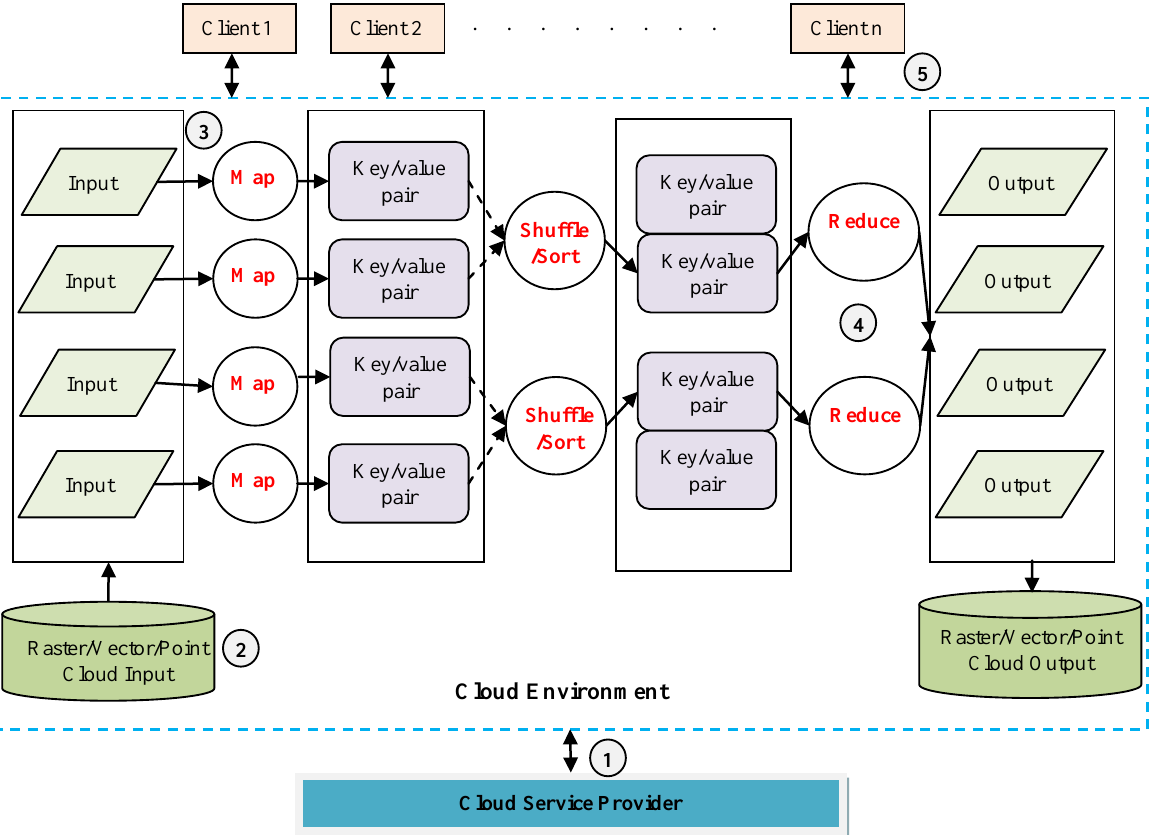
Figure 4. Cloud enabled hadoop